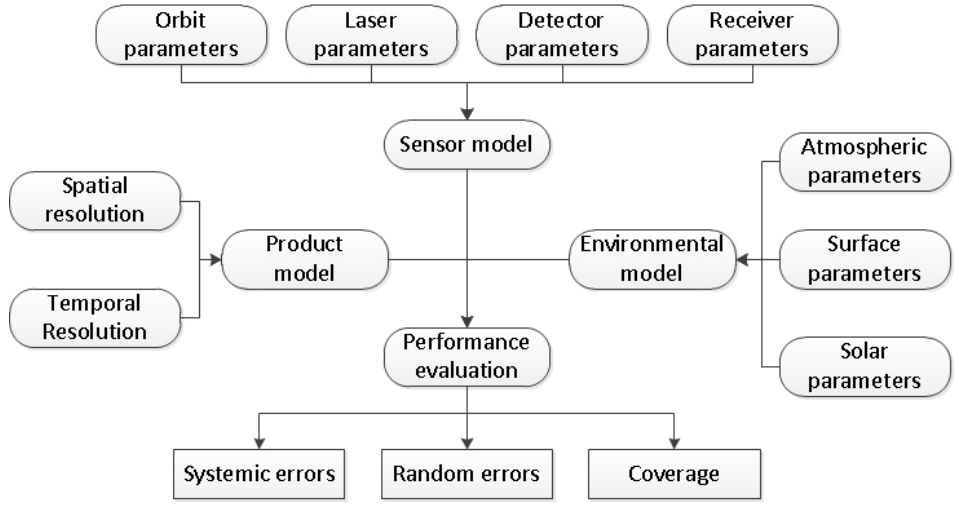
Figure 1. Overall schematic diagram for the work carried out in this study.